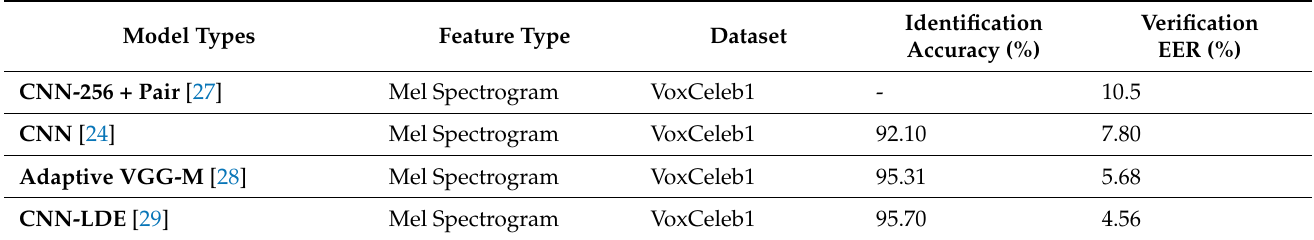
Table 7. Comparison of Speaker Identification and Verification Performance of Cochleogram with existing